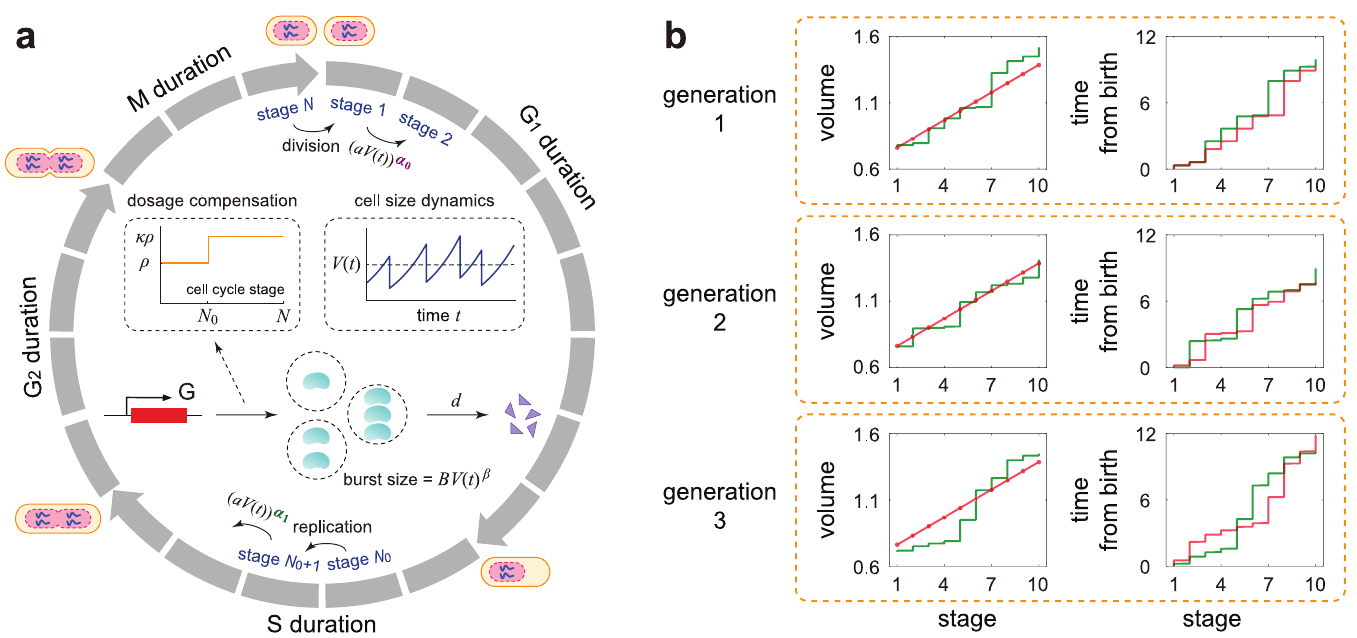
Fig 1. Model and its mean-field approximation. A : A detailed stochastic model with both cell size and gene expression descriptions. The model consists of N effective cell cycle stages, gene replication at stage N 0 , cell division at stage N , bursty production of the gene product, and degradation of the gene product. The growth of cell volume is assumed to be exponential and gene dosage compensation is induced by a change in the burst frequency at replication from ρ to κ ρ with κ 2 [1, 2) (see inset graphs). Both the transition rates between stages and the mean burst size depend on cell size in a power law form due to size homeostasis and balanced (or non-balanced) biosynthesis, respectively. The model also considers two-layer cell-size control with its strength varying from α 0 to α 1 upon replication. B : Schematics of the changes in cell volume and time from birth as a function of cell cycle stage k for the first three generations in the case of N = 10 and α 0 = α 1 = 1. In the full model (green curve), the gene expression dynamics is coupled with the following two types of fluctuations: noise in cell volume at each stage and noise in the time interval between two stages. The reduced model (red curve) ignores the former type of fluctuations by applying a mean-field approximation while retaining the latter type of fluctuations. Note that when α 0 = α 1 = 1, it follows from Eq (3) that the mean cell volume at stage k is v k = v 1 + ( k − 1) M 0 / N 0 , which linearly depends on k . The red dots in the stage-volume plot show the dependence of v on k and the joining of these dots by a straight red line is simply a guide to the eye. The reduced model approximates the full model excellently when k N is sufficiently